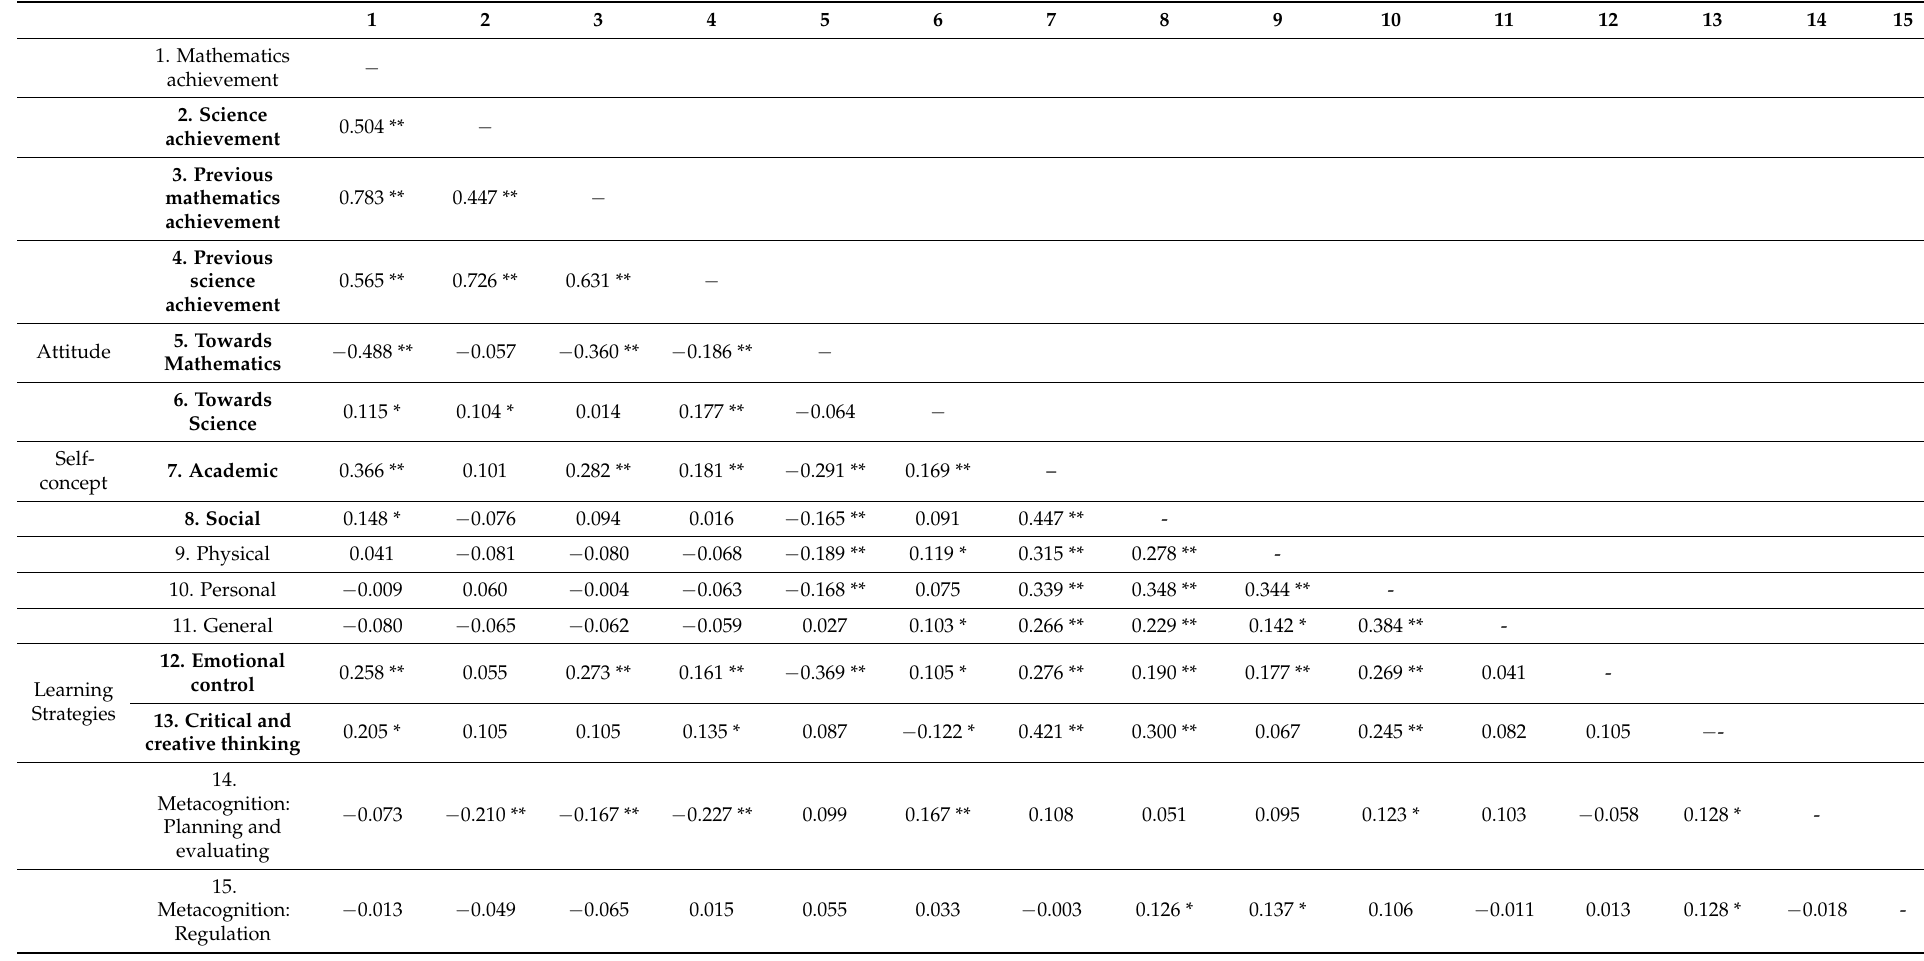
Table 2. Spearman’s correlations between mathematics achievement and other variables of interest (* p < 0.05, ** p < 0.001; bilateral